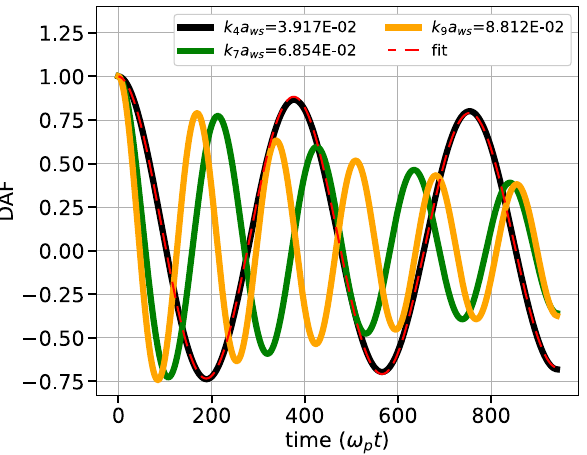
Figure 1. DAF curves generated using MD simulations (solid lines) and curve obtained by fitting MD data with Eq. (19) (broken lines) for Ŵ = 60 and κ =